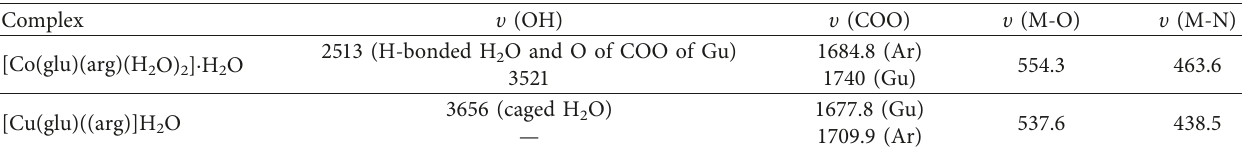
Table 3: Experimentally and theoretically simulated IR spectra (in cm − 1 ) of the studied complexes. Assignment of theoretically calculated IR key modes for Co(II) and Cu(II) complexes in the gas phase. Excellent match between experimentally determined and theoretically computed IR modes in case of Ni and Zn complexes is